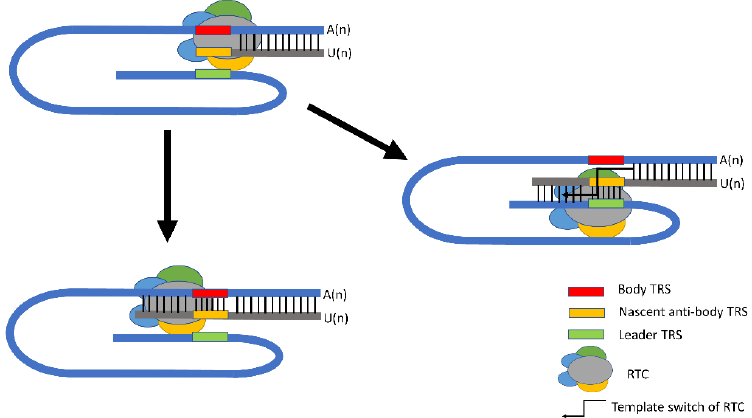
Figure 2. A discontinued replication model for PEDV. When RTC encounters TRS region, it will either “read through” or “template switch” to generate discontinued sgRNAs. Modified from Baker, S.C., 2008 [62].